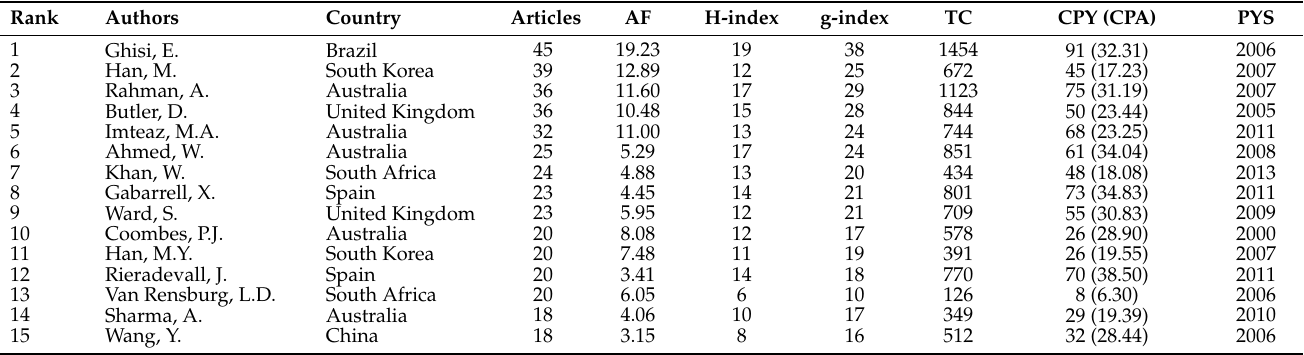
Table 6. The top 15 productive authors in RWH